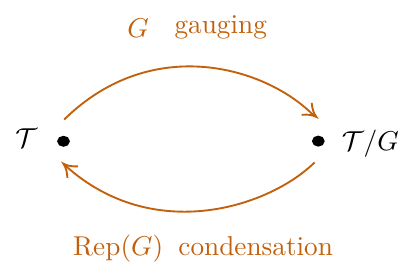
Figure 9 . Gauging and condensation are